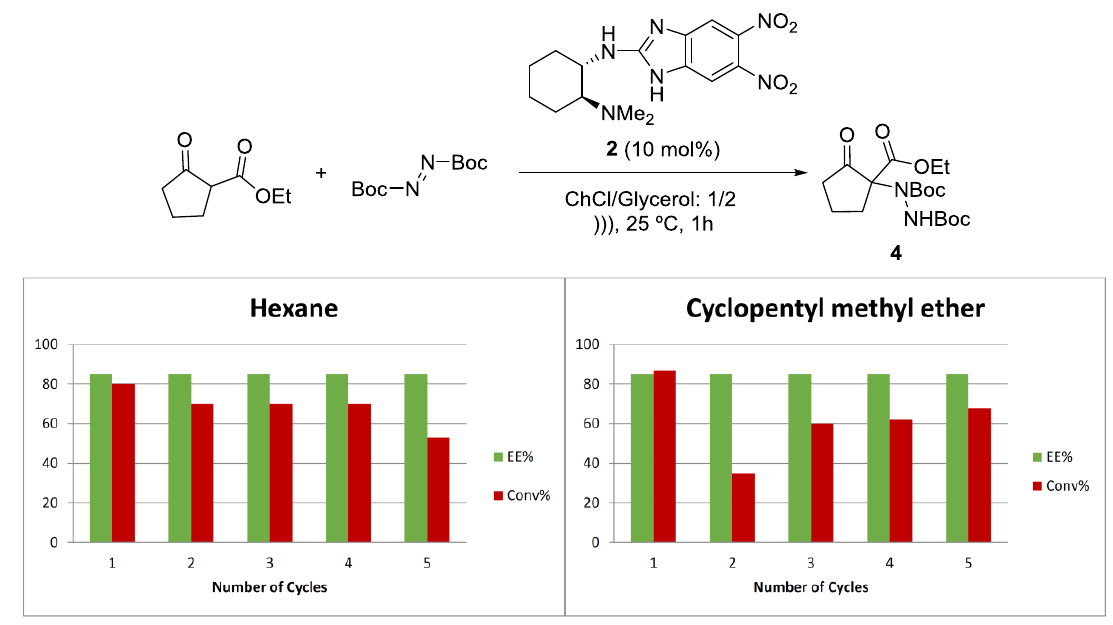
Table 3. Asymmetric α-amination catalyzed by 3 . Reaction scope.